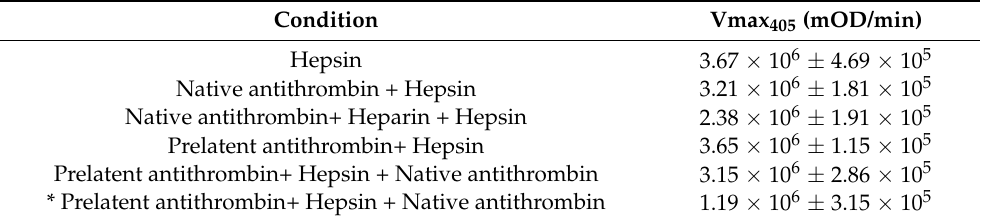
Table 2. Hepsin activity using its fluorogenic substrate after incubation with